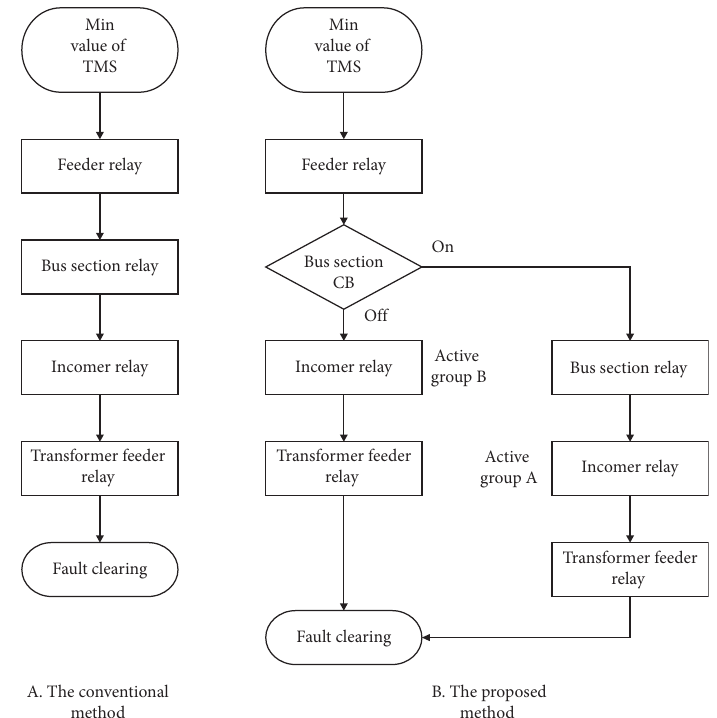
Figure 9: Relays coordination, (a) conventional method, (b) proposed method. Figure 4. For the setting and coordination of the OC relay, Table 1: Relay pickup plug setting (PS) and time multiplier setting (TMS) are needed for each relay in the system. PS depends on the max load and can be determined by a load flow study, while TMS is computed based on the discrimination time margin needed between the relays.